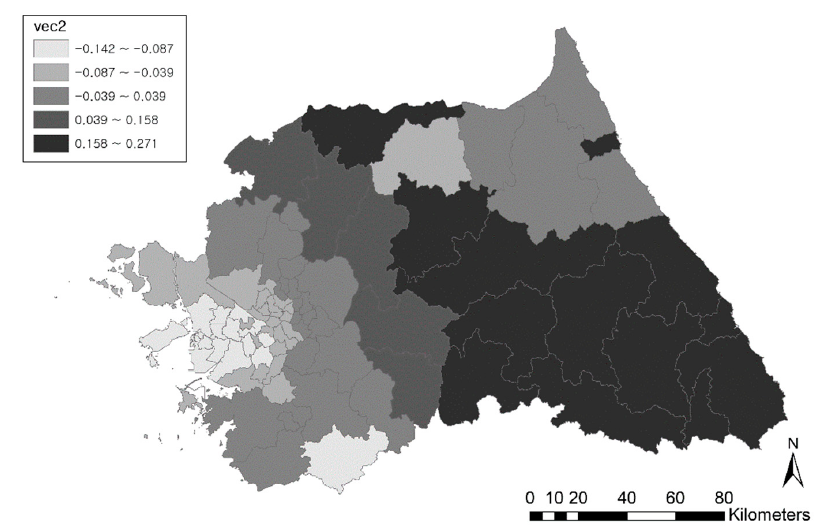
Figure 5. Spatial pattern of eigenvector no. 2.